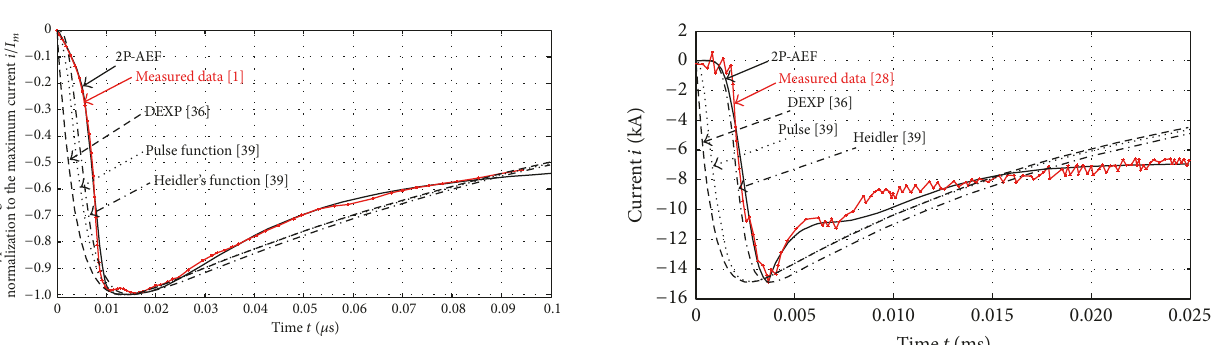
Figure 15: Measured rocket-triggered lightning current [28] and its approximations by DEXP, Pulse, Heidler’s function, and 2P-